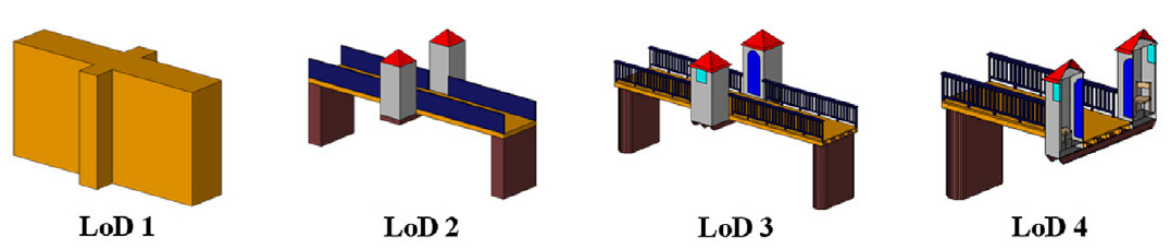
Figure 2: The four levels of detail (LoD) defined in CityGML (taken from (Gr¨oger and Pl¨umer, 2012))